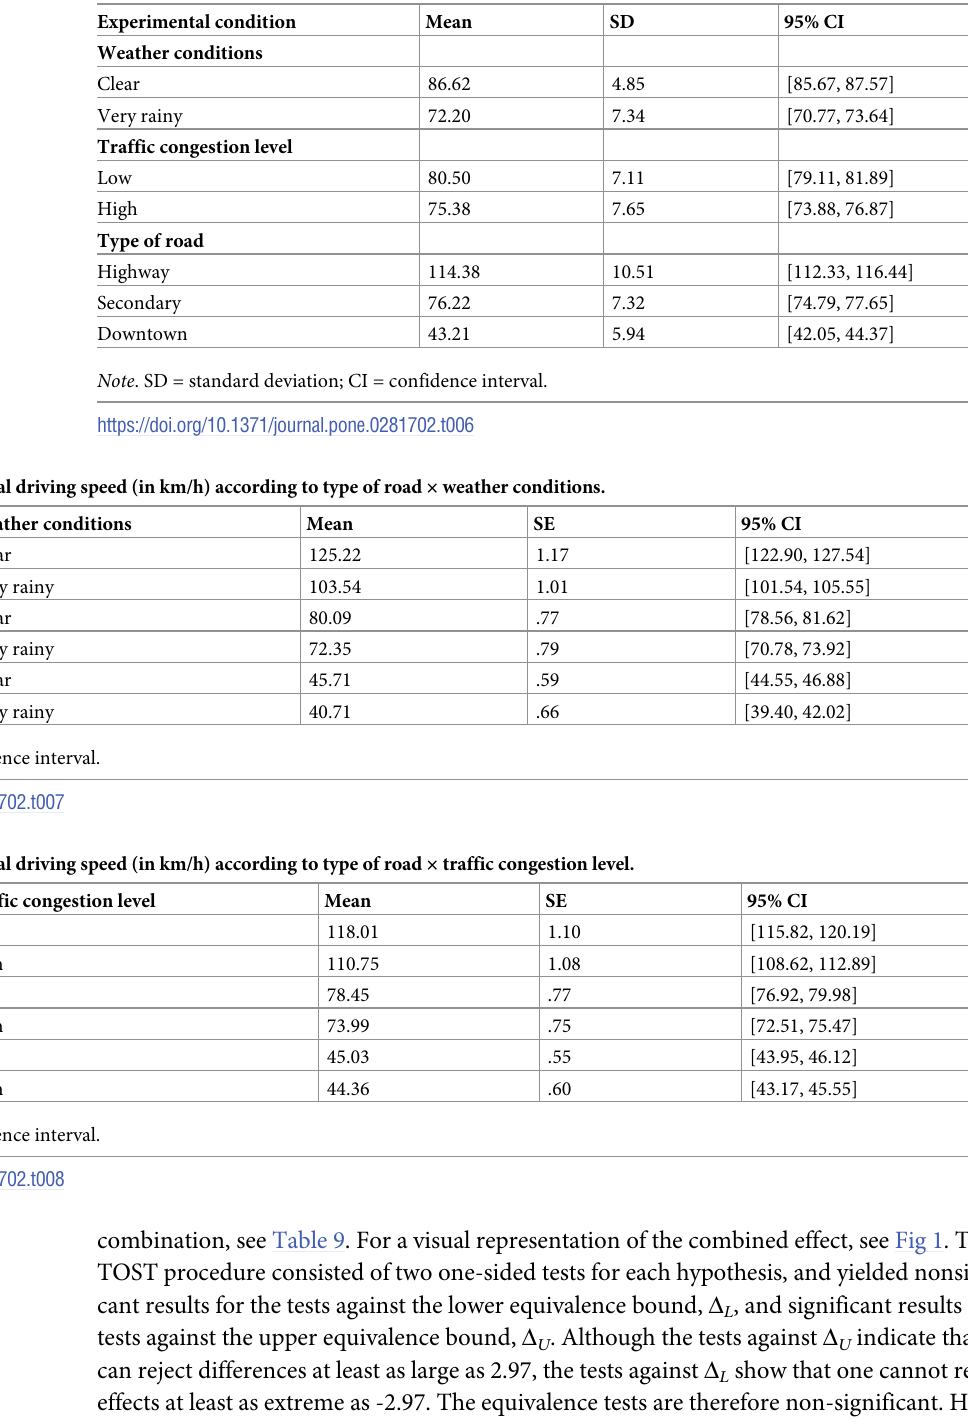
Table 6. Participants’ preferred AV speed (in km/h) in the different experimental conditions.